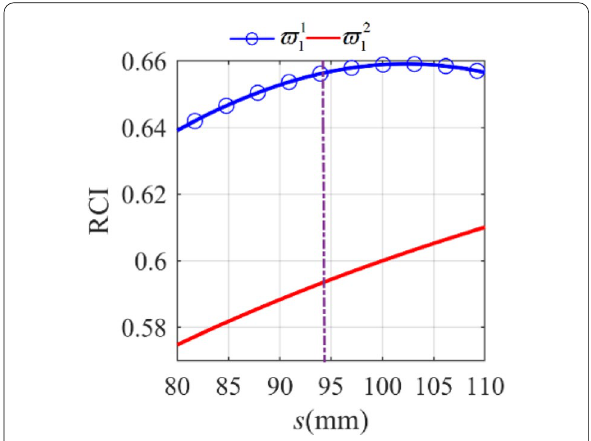
Figure 15 RCI near the mixed